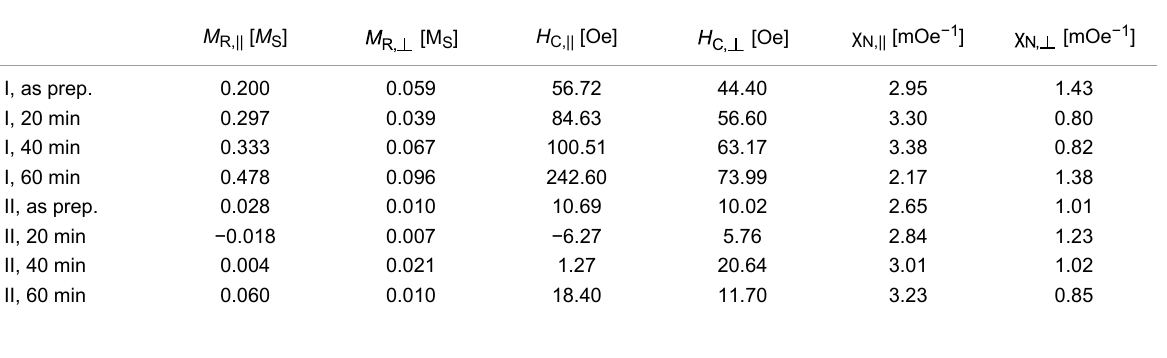
Table 1: Characteristic magnetic data obtained from AGM measurements for sample I and II for different plasma treatment times. Measurements were taken at room temperature.